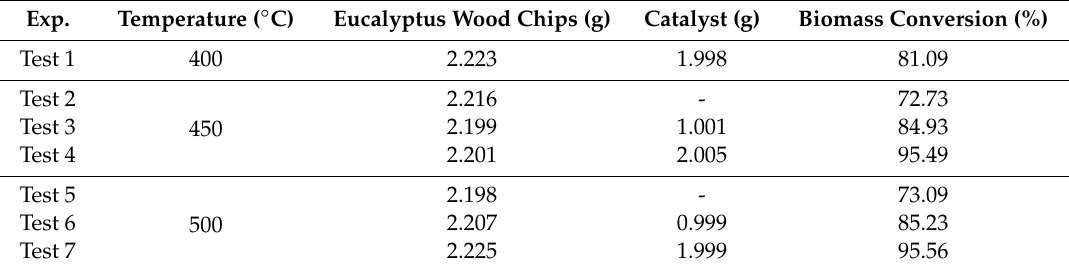
Table 1. Catalytic supercritical water gasification (CSCWG) testing and biomass conversion using a reaction time of 60